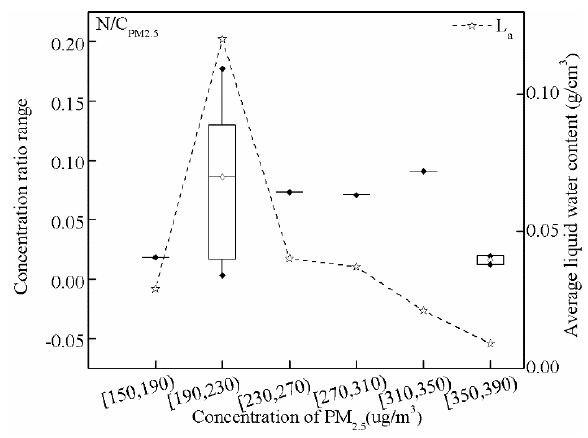
Figure 7. Changes of C PM10 ( a ), C PM2.5 ( b ), and C PM10 /C PM2.5 ( c )during the four stages in Case 2.